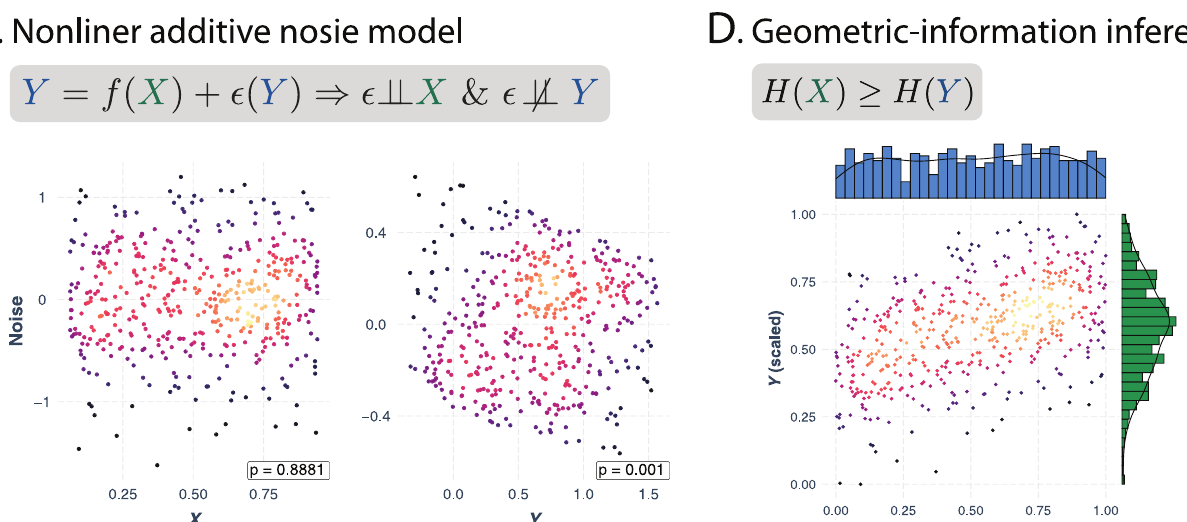
Fig 2. Illustration of the causal discovery methods. Panel ( A ) shows a hypothetical dataset where X is the cause and Y is the effect. We generate this dataset as an ensemble y * x d with white noise, where d ranges from 0.5 to 1. The color of the points represents the density of data: the darker it is, less points it represents. Panel ( B )-( D )illustrate three causal discovery methods we adopted. Panel ( B ) illustrates the method based on formal logic. The criteria of X being the cause is that the proportion of points with small x and large y values is greater than that of points with large x and small y values. The marginal distributions are both normalized to keep roughly equal proportions of small and large samples. Normalization can help avoid the bias in the method regarding skewed marginal distributions. Panel ( C ) illustrates the method based on nonlinear additive noise model. This method assumes that the effect (i.e., Y ) is some potentially nonlinear transformation of the cause (i.e., f ( X )) plus some noise that is independent of the cause (i.e., � ( Y )). The criteria of X being the cause is that the residuals from the regressions should be independent of X but not of Y . The form of the nonlinear transformation f ( X ) and consequently the residuals can be fitted through nonparametric regressions. Panel ( D ) illustrates the method based on information theory. The criteria of X being the cause is that X has a higher entropy than Y . The marginal distributions are both scaled via a linear transformation between 0 and 1 for a fair comparison of